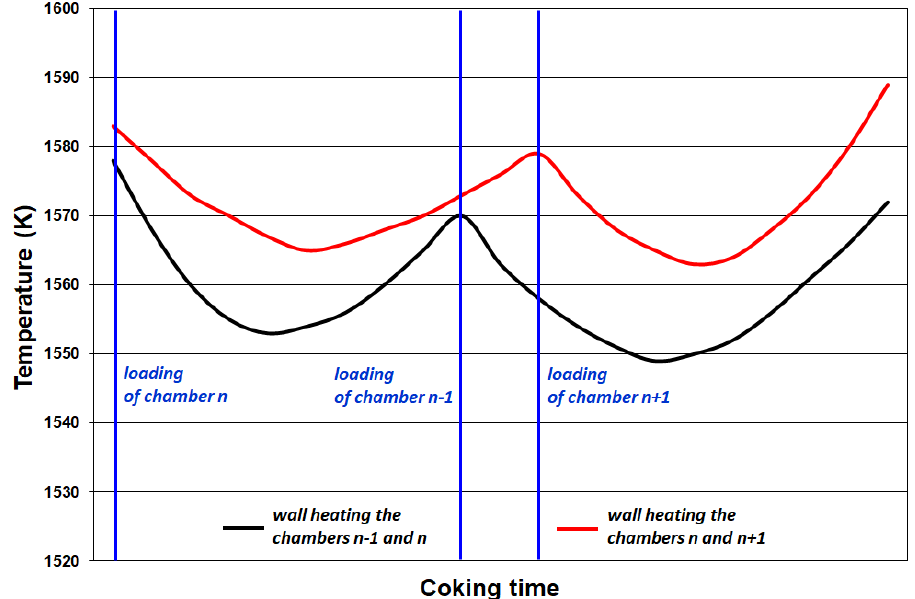
Figure 4. Temperature changes during the coking process on the bottom of the heating flues for two adjacent heating walls measured at one of the Polish coke oven battery [2].